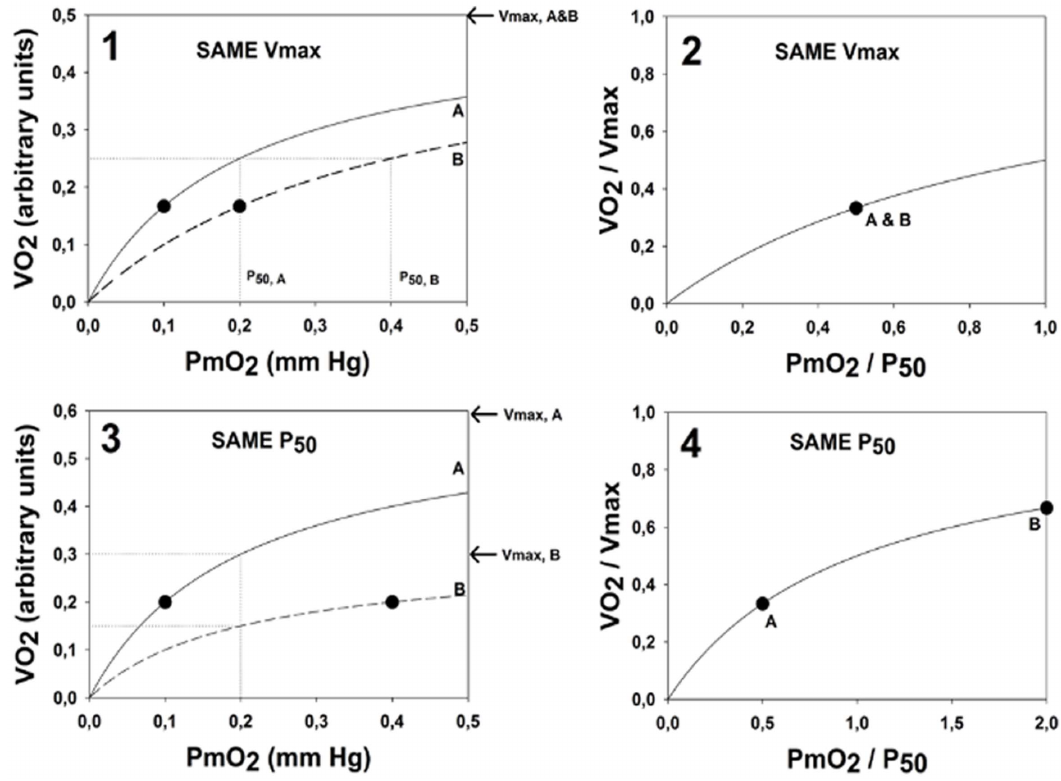
Figure 2. Importance of normalizing both actual _ VV O P 50 when _ VV max and/or P 50 may vary within or between muscles. Panel 1: Example of two muscles (A & B) with the same _ VV max but